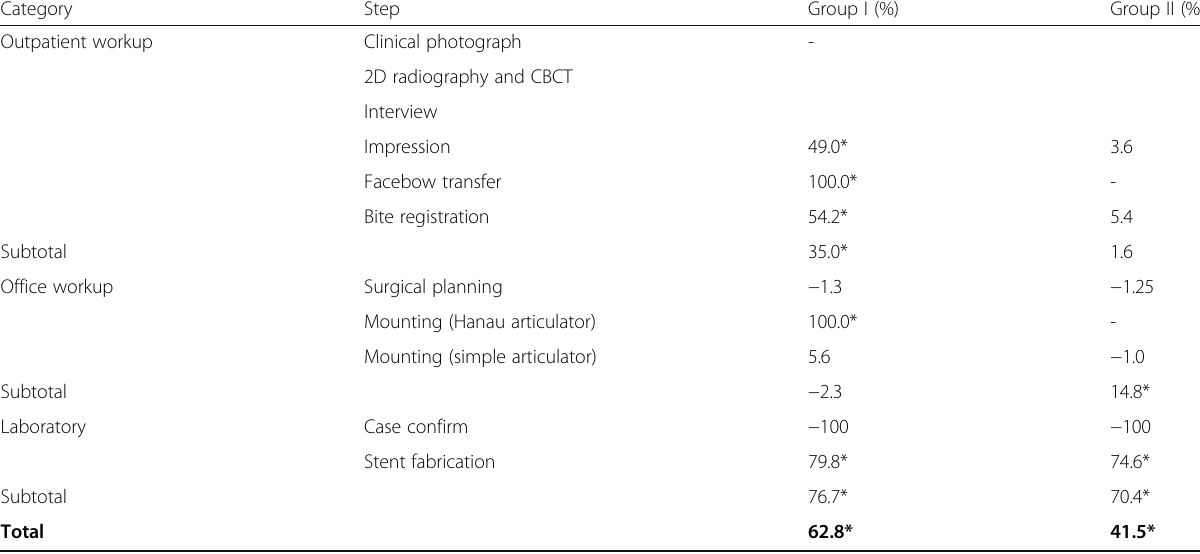
Table 3 Time reduction rate for each category in VSP comparing with CSP Category Step Group I (%) Group II